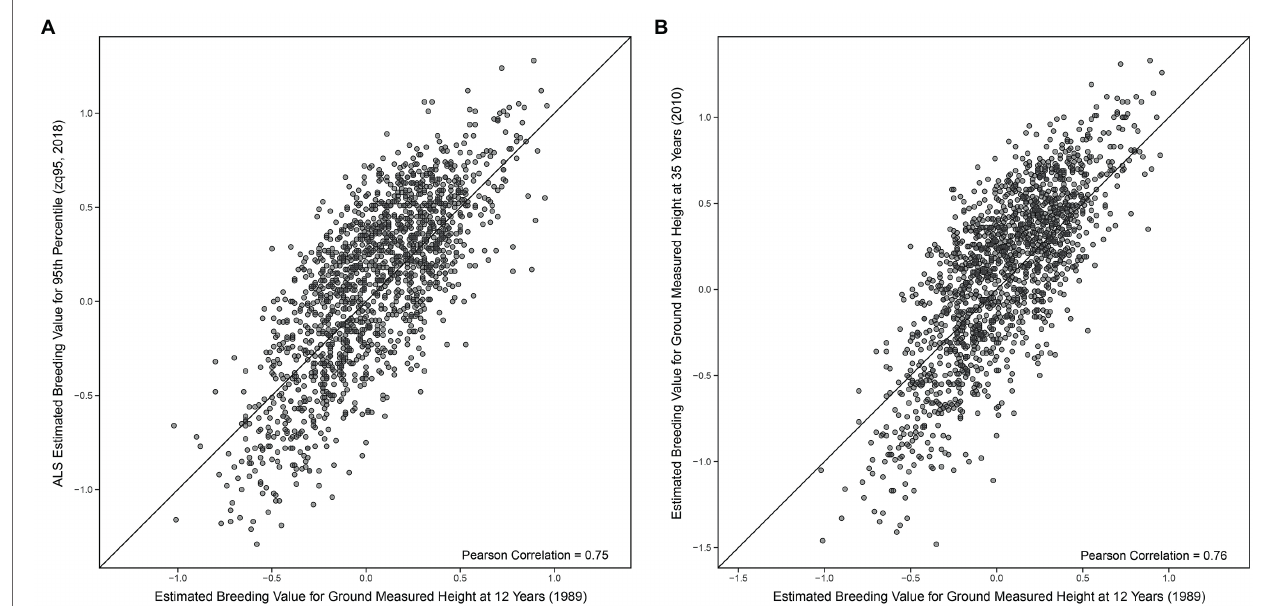
FIGURE 4 | (A) Comparison of univariate estimated breeding values (Equation 1) for the 95th percentile of height-derived from ALS taken in 2018 and field- measured height at 12 years in 1989. The black line represents a 1:1 fit. (B) Comparison of univariate estimated breeding values (Equation 1) of field-measured height at 35 years in 2010 and field-measured height at 12 years in 1989. The black line represents a 1:1 fit.